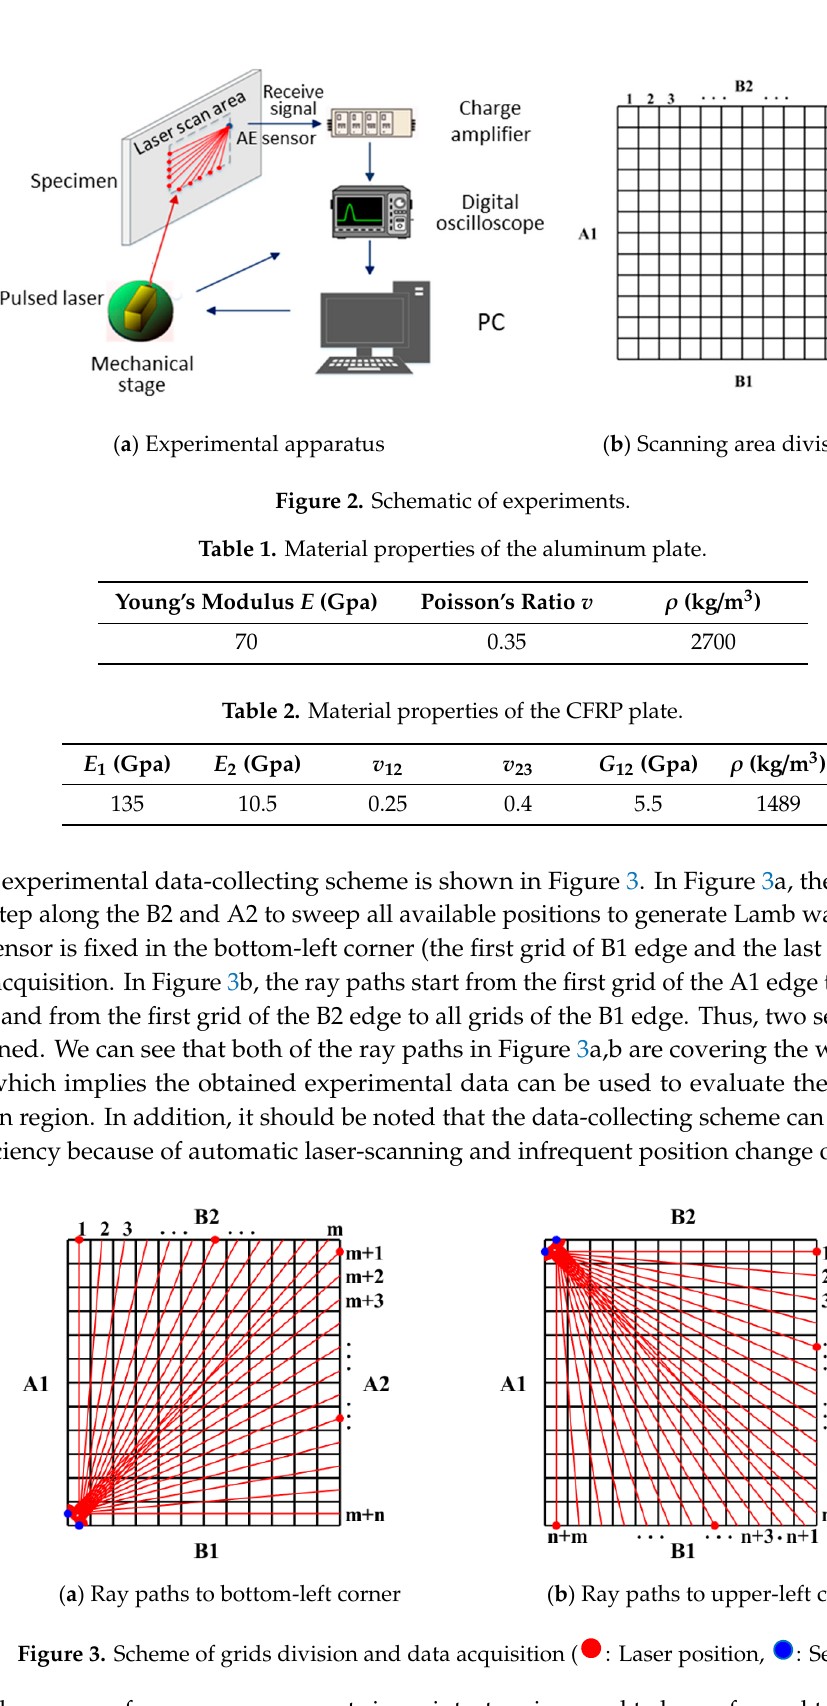
Table 2. Material properties of the CFRP plate.